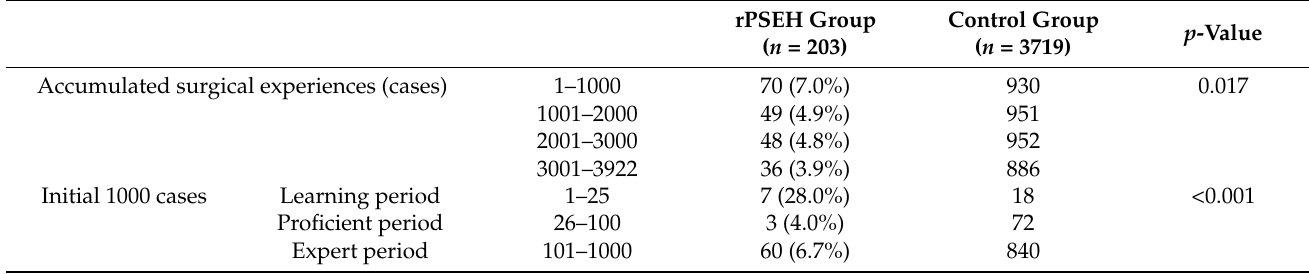
Table 1. The incidence rate of radiographic postoperative spinal epidural hematoma based on the number of surgical